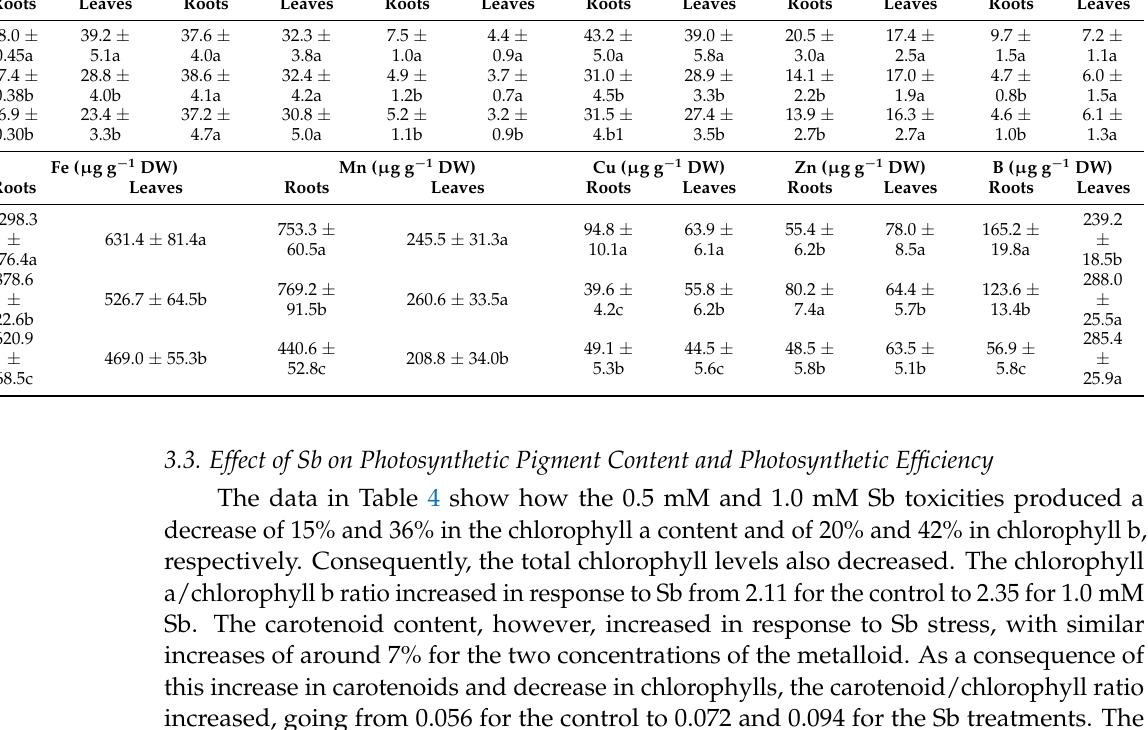
Table 3. Effect of Sb on the mineral element content of roots and leaves of D. viscosa plants. The data are from 10 independent experiments, each carried out in triplicate (different letters indicate significant differences at p < 0.05, Mann–Whitney U-test). Treatments